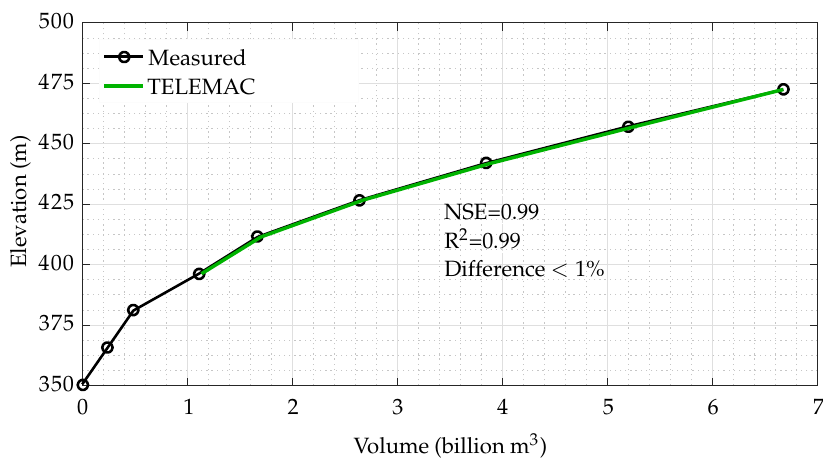
Figure 5. Comparison between the computed elevation-storage volume and observation for 1983.